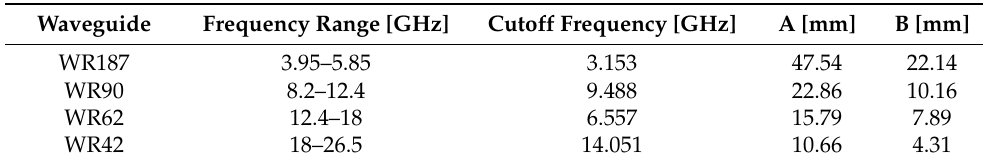
Table 1. The waveguide parameters used in our experiments.